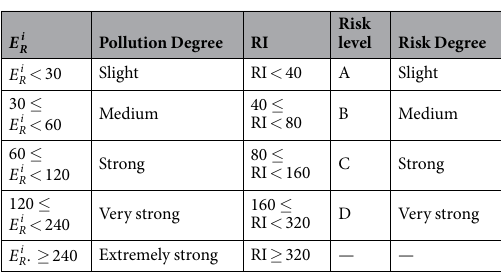
Table 4. Heavy Metals Grading Standard of Potential Ecological Risk 28 .